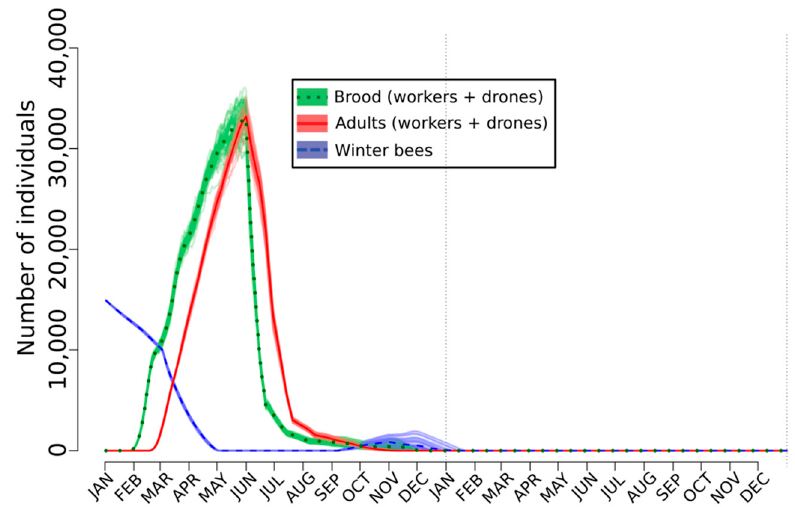
Figure 3. Combined effects of the rejection of the emergent bees and a decrease in the efficacy of the nurses on the population dynamics of A. mellifera simulated with the agent ‐ based model SimBeePop.